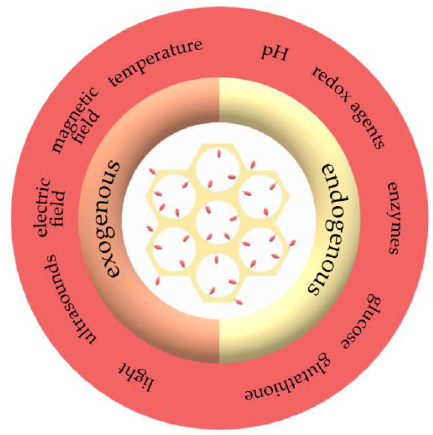
Figure 6. The main exogenous and endogenous stimuli involved in stimuli-responsive mesoporous silica systems.